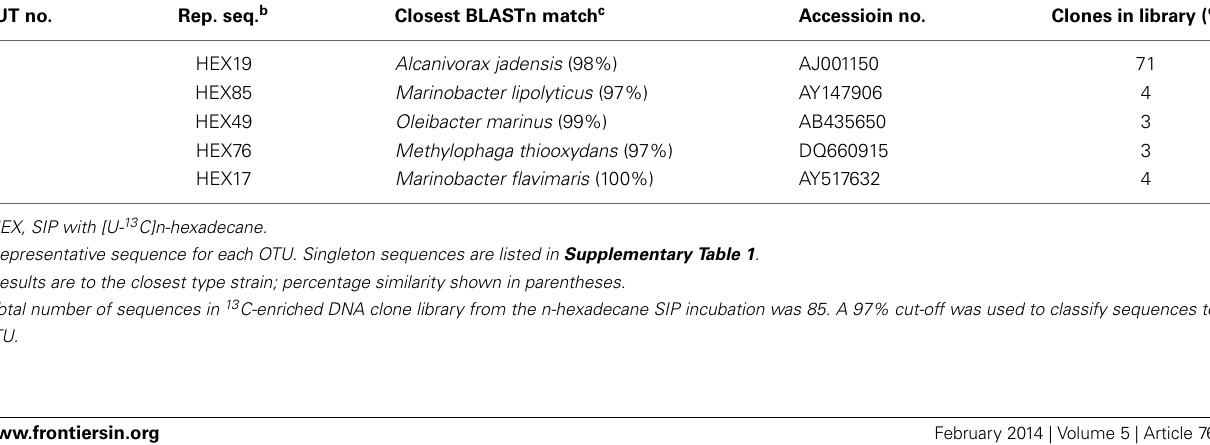
Table 2 | SIP-identified sequences in the clone library constructed from 13 C-enriched DNA a . OUT no.